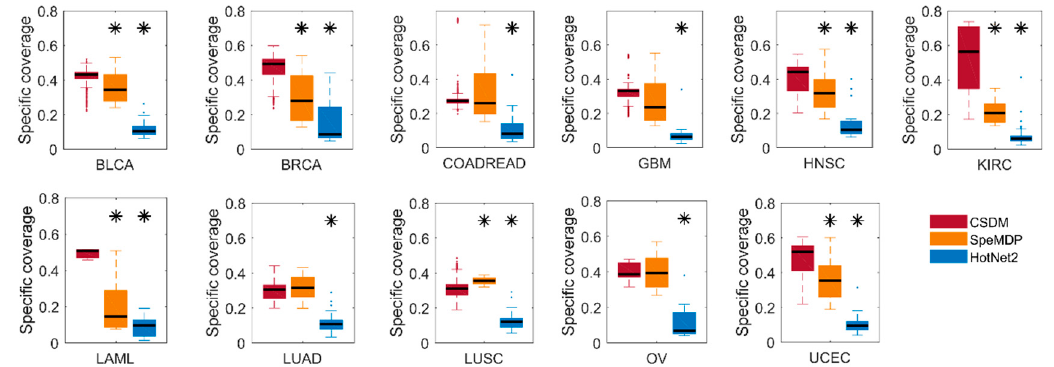
Figure 1. Comparison of CSDM (red), SpeMDP (yellow), and HotNet2 (blue) and their specific coverage in 11 different cancer types. The stars above the blue and red bar represent the differences between CSDM and SpeMDP and HotNet2 in specific coverage, which are computed using Fisher’s exact test (* p < 0.05). The confidence intervals for the boxplots correspond to q1 − 1.5 × (q3 − q1) and q3 + 1.5 × (q3 − q1), where q1 and q3 are the 25th and 75th percentiles, respectively.